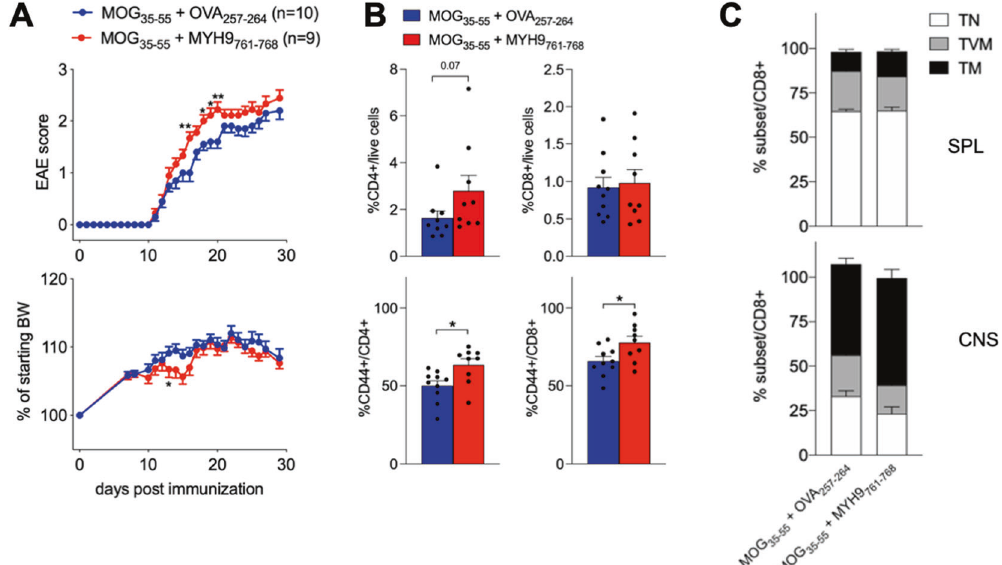
Fig. 6 MYH9 761-768 immunization exacerbates EAE disease course. C57BL/6 mice were immunized with 100 µg MOG 35-55, admixed with OVA 257-264 ( n = 10) or with MYH9 761-768 ( n = 9), and received 200 ng B. pertussis Toxin (PTX) i.p. at days 0 and 2. A EAE score and changes in body weight were monitored. * P < 0.05, ** P < 0.01, by Mann – Whitney test. B, C Mice were sacri fi ced at day 29 and fl ow cytometry analysis was performed in spleens (SPL) and central nervous system (CNS). B Percentages of total CD4 + and CD8 + T cells (upper panels), and of CD44 + CD4 + or CD8 + T cells (lower panels), in the CNS of mice immunized with MOG 35-55 plus OVA 257-264 (blue) or plus MYH9 761-768 (red). * P < 0.05, by Mann – Whitney test. C Percentages of T naïve (T N ), T virtual memory (T VM ), and T memory (T M ) in gated CD8 + T cells from SPL or CNS of mice immunized with